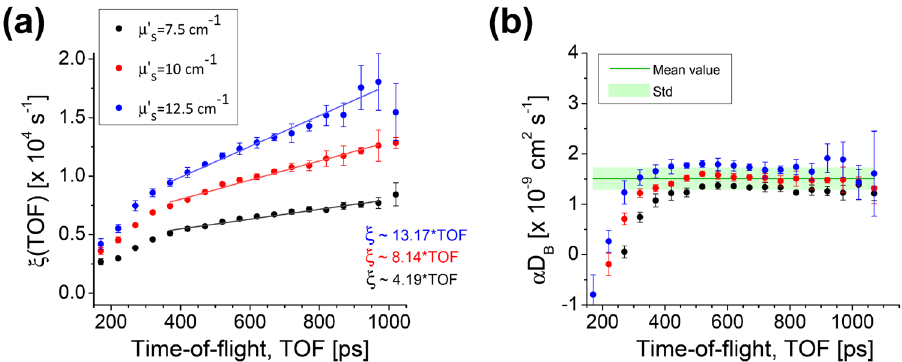
Figure 2. Estimating the diffusion coefficient of homogeneous phantoms with the time-domain diffuse correlation spectroscopy. ( a ) The autocorrelation decays were obtained using the standard model for the variable time-of-flight (TOF). The resulting decays were fitted to a line, from which we estimate the diffusion coefficient ( b ).